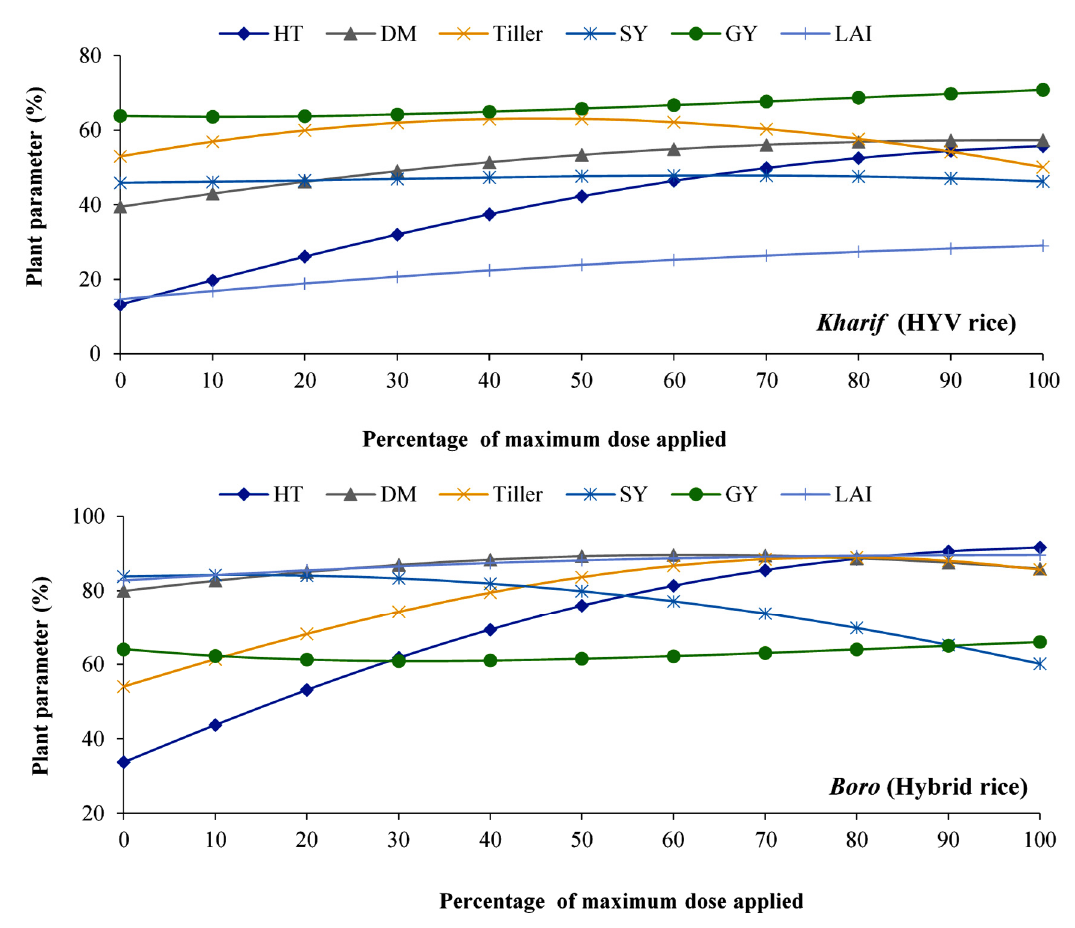
Figure 5. Effect of zinc on different plant parameters of rice in both kharif and boro seasons. For notation, see Figure 2.